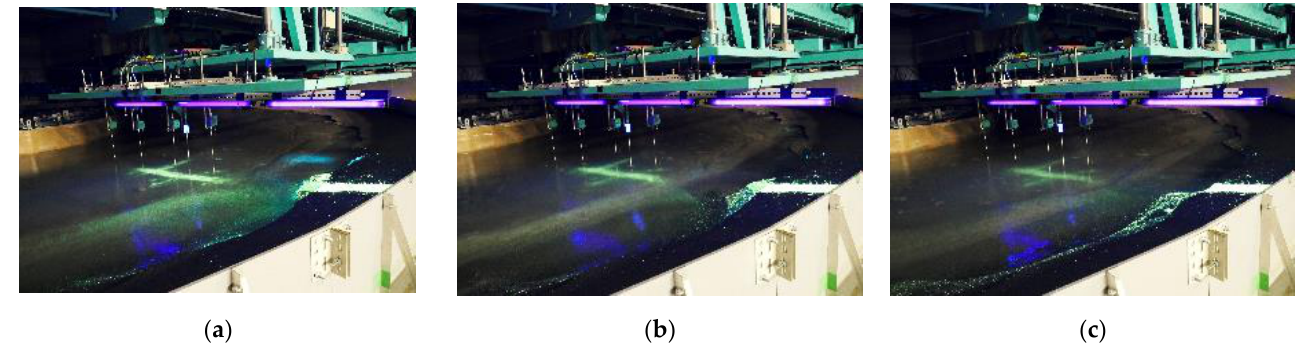
Figure 14. Snapshots of fluorescent sands movement during the experiment in Case 2a: ( a ) after 1 min ( b ) after 20 min ( c ) after 60 min.